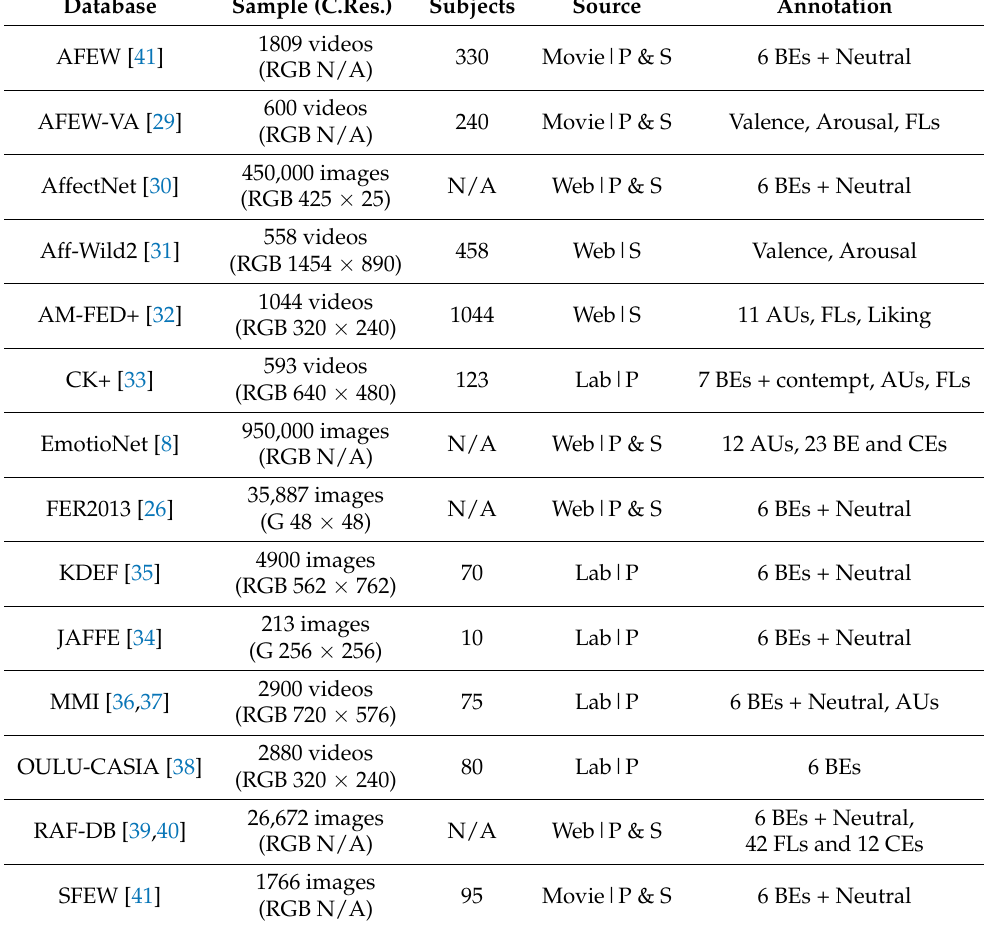
Table 1. Principal databases used in FER systems (C. = color; Res. = resolution; G = grayscale; RGB = RGB-colored; P = posed (expression); S = spontaneous (expression); BE = basic emotion; AU = action unit; CE = compound emotion; FL = facial landmark).